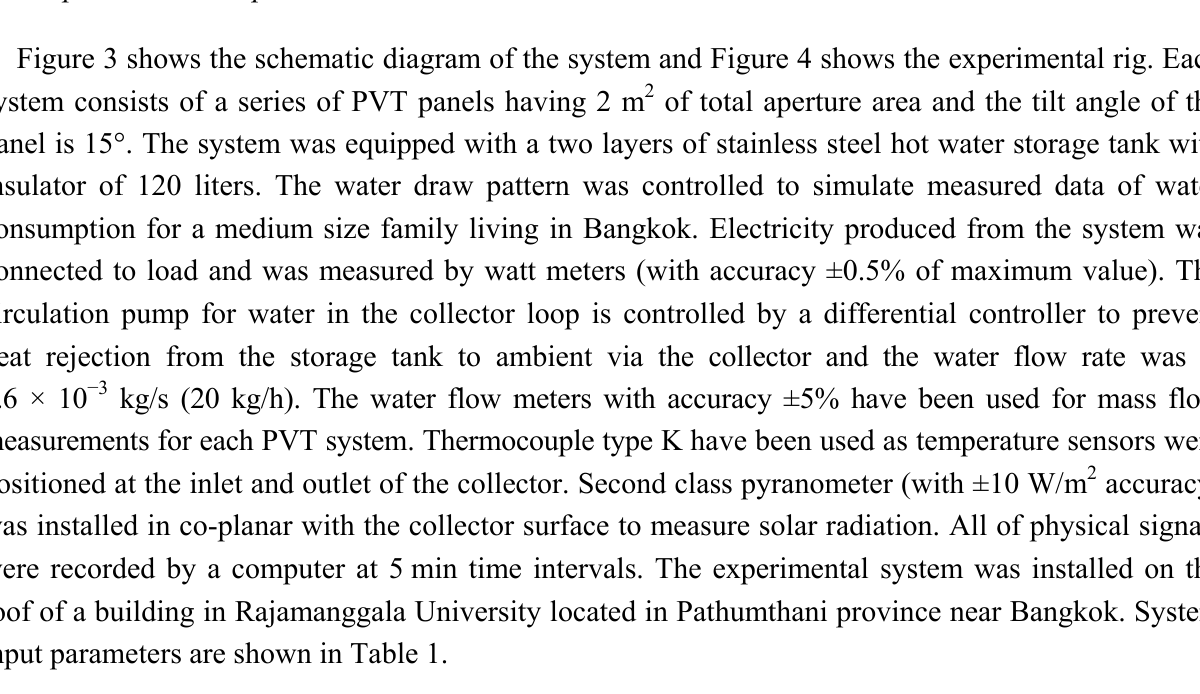
Figure 3. Schematic of PVT